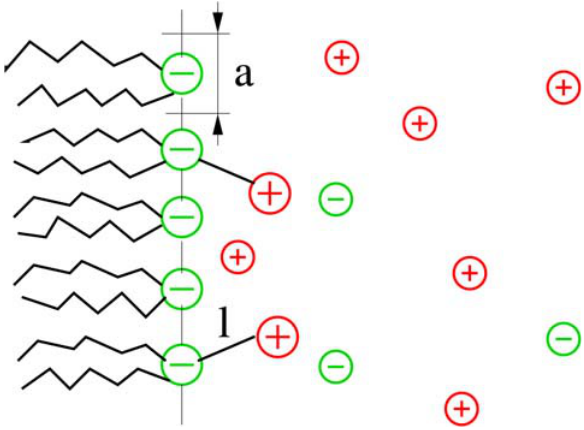
Figure 1 . Schematic presentation of zwitterionic lipid layer. The length of head group is l , whereas the cross-section area per lipid molecule is a